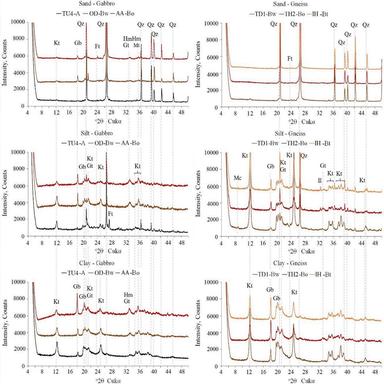
X-ray diffractograms of sand, silt, and clay fractions of the studied soils in Brazil. TU4 − Typic Ustorthent, OD − Oxic Dystrustept and AA − Anionic Acrudox derived from gabbro; TD1 − Typic Dystrustept, IH − Inceptic Hapludult and TH2 − Typic Hapludox derived from gneiss; Kt − Kaolinite, Mc − muscovite, Gb − gibbsite, Gt − goethite, Hm − hematite, Fp − feldspar, Qz − quartz, Mh − maghemite, Il − Illite.